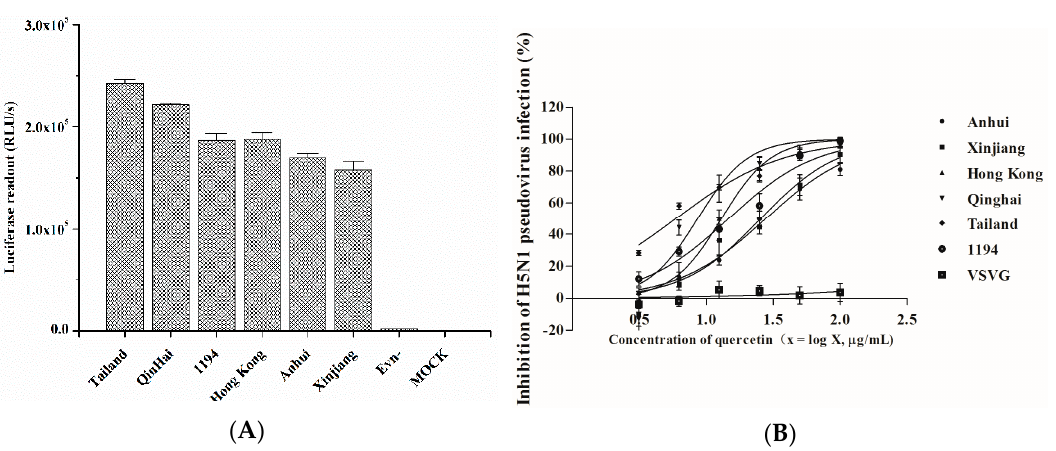
series of H5N1 pseudoviruses, named A/Anhui/1/2005A, A/Xinjiang/1/2006, A/HongKong/156/1997,